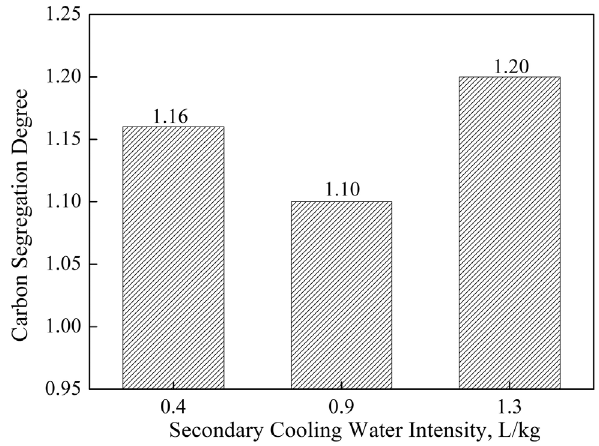
Fig. 8: The measured center carbon segregation degree of 82B steel under different secondary cooling water